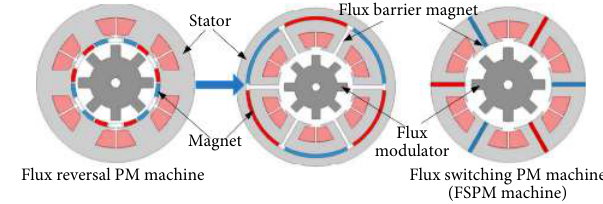
Fig. 19 Topology transferring from flux reversal to flux switching PM ma- chine (reprinted with permission from Ref. [57], © 2015 IEEE).